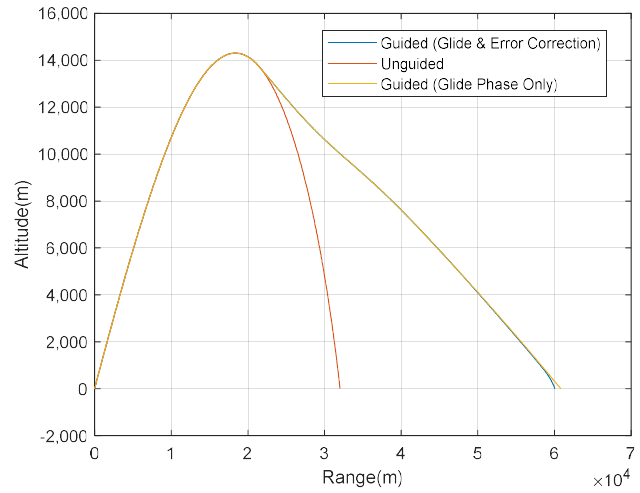
Figure 19. Altitude vs. Range.